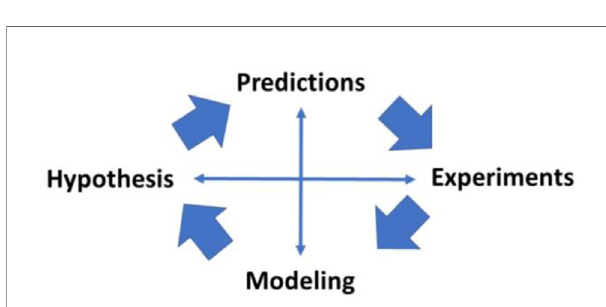
FIGURE 19 | Importance of modeling in the scienti fi c